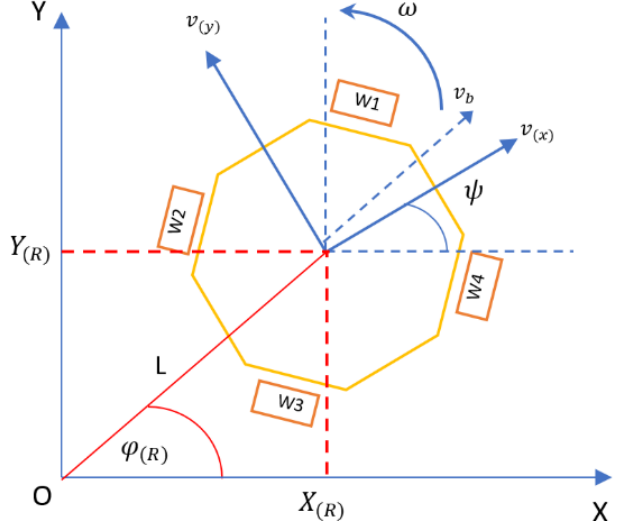
Figure 2. The coordinates and orientation of the robot to the global coordinates of